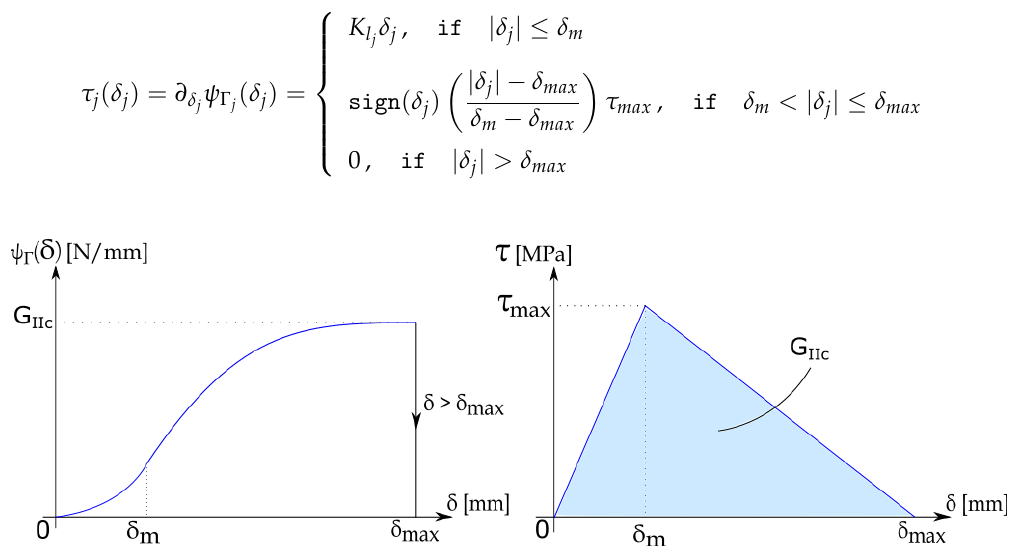
Figure 3. Interface internal potential energy and bilinear τ − δ diagram used in